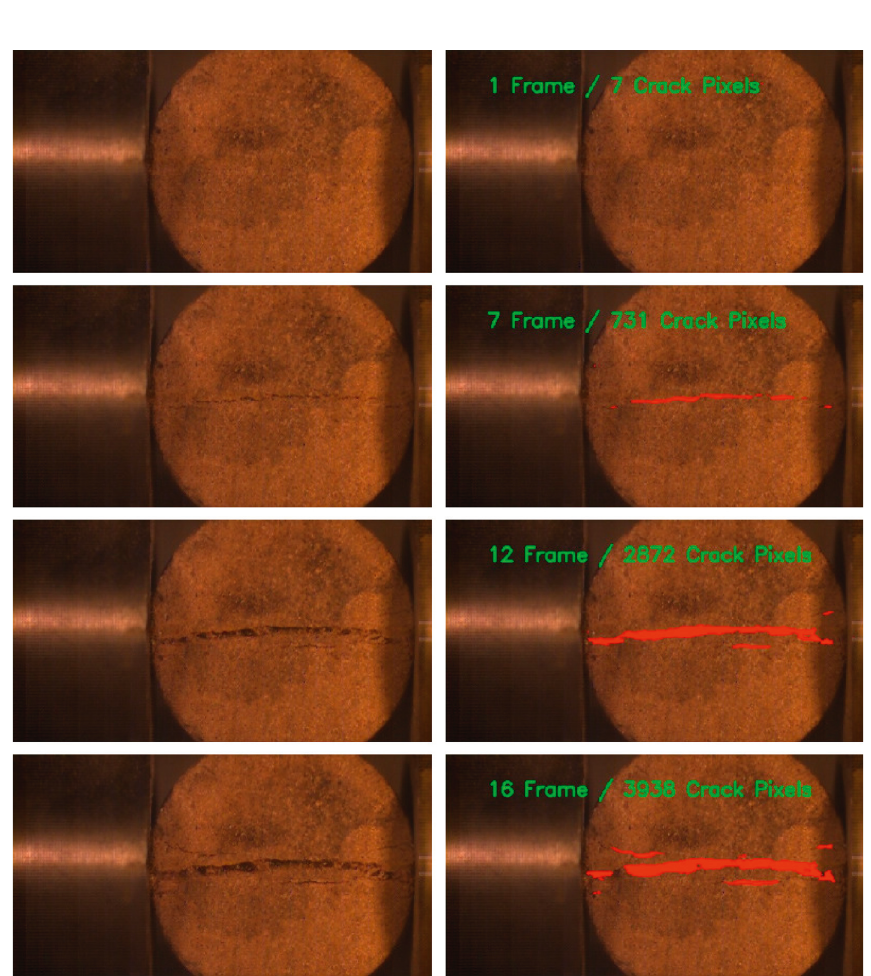
Figure 11: Example of crack identification